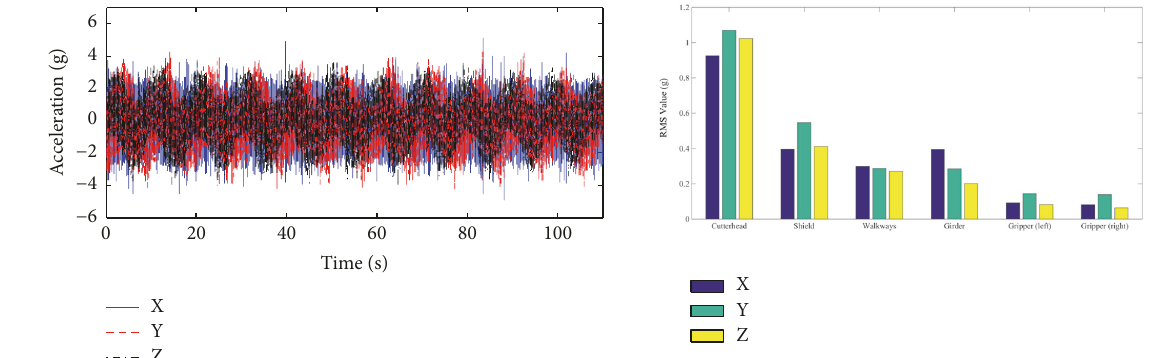
Figure 7: Vibration acceleration curves of the cutterhead point and the RMS value of each test